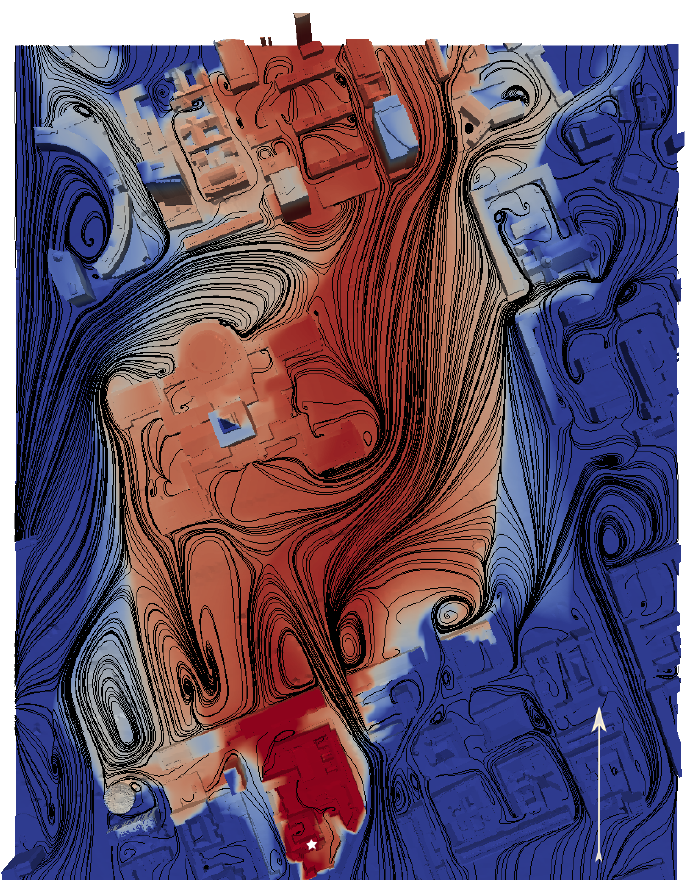
Figure 2. Visualisation of the ground concentration of a pollutant on a logarithmic scale that was released on a roof top (white star), which is in the bottom part of the figure. The complex wind field is visualised using streamlines, and the inflow wind direction is given by the white arrow. The geometry is that of the Parade Square in Warsaw,